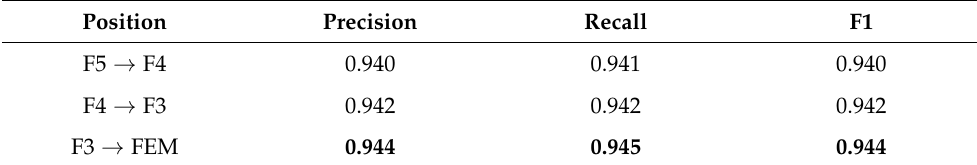
Table 5. Effects of TRsB at different locations.